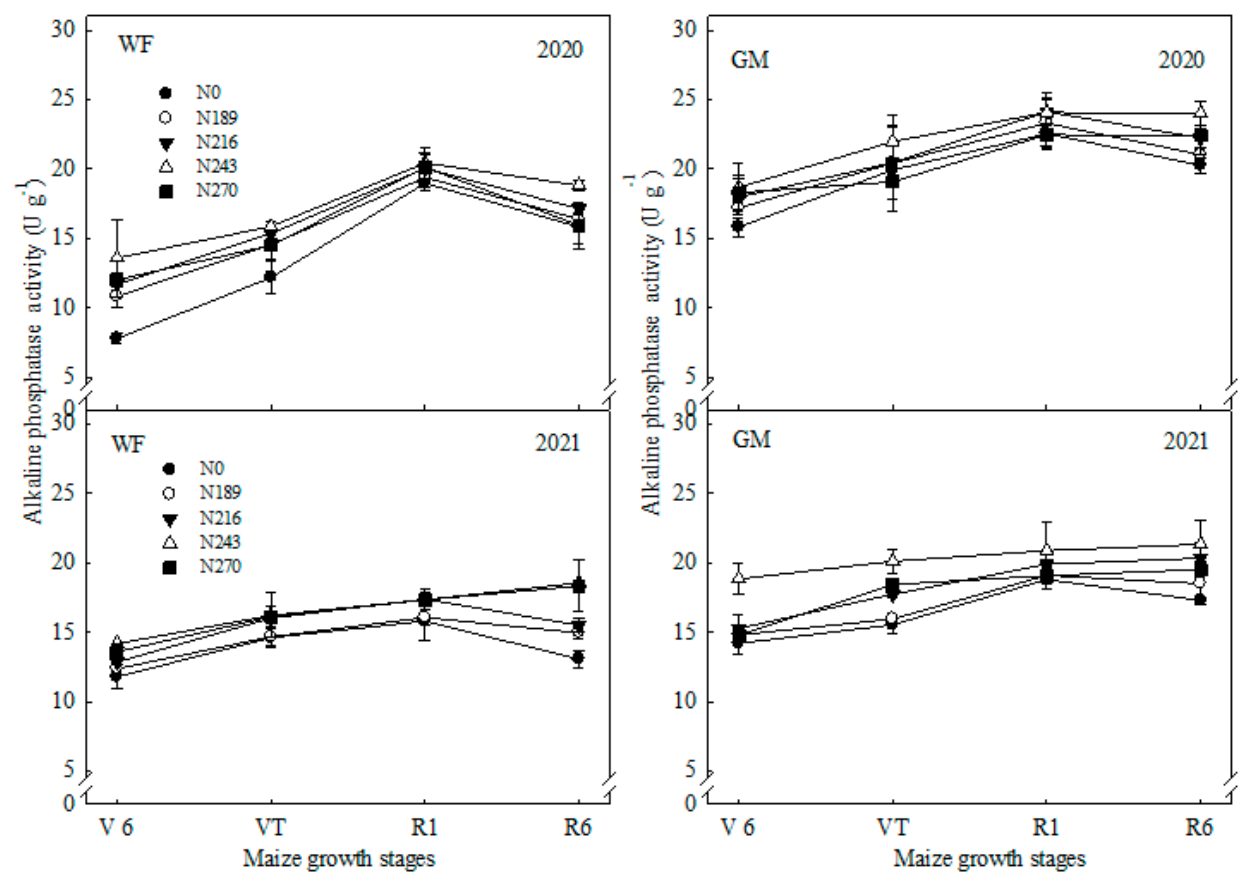
Figure 5. The soil alkaline phosphatase activity response to N application under WF and GM treatments in the North China Plain. V6, spring maize jointing stage; VT, spring maize tasseling stage; R1, spring maize filling stage; R6, spring maize maturity stage.